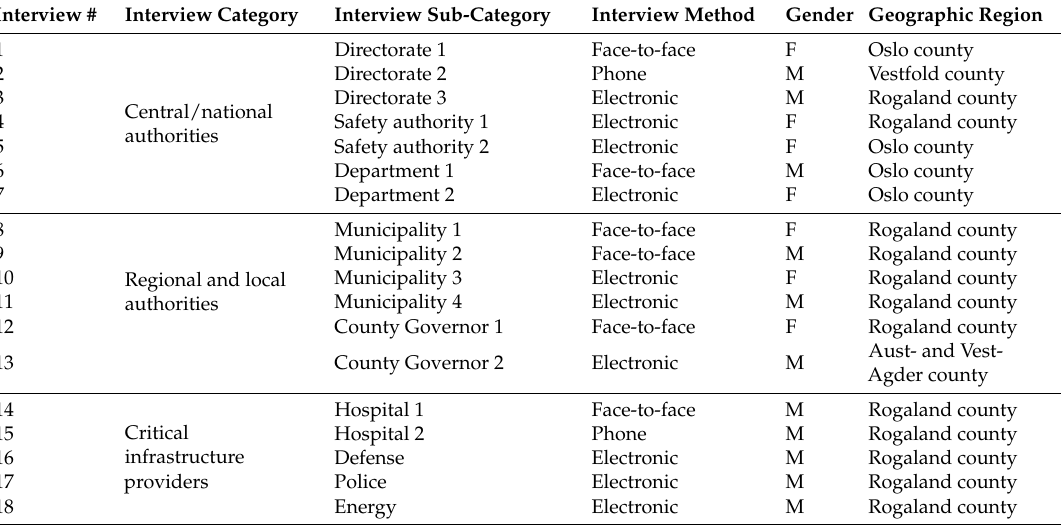
Table 1. Sample and methods used in the empirical